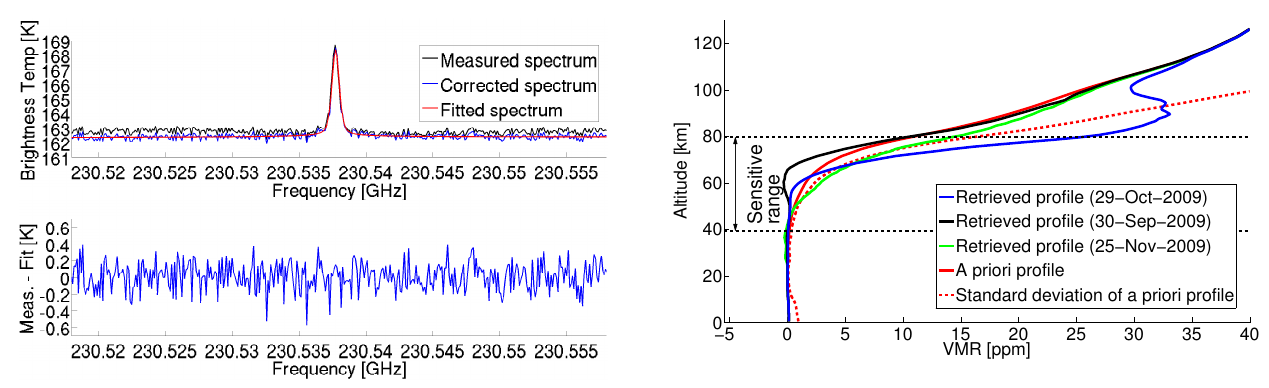
Fig. 3. Retrieved CO profiles (selected to cover the complete range of the CO change during a winter), as well as the constant a priori profile and its assumed standard deviation represented by q S ii a · x i a . The range of sensitivity of the KIMRA CO measure- ments (Sect. 3.4) is marked with black dashed lines. Out of this range the profiles are not reliable, but are shown here for a com- plete demonstration of the retrieval